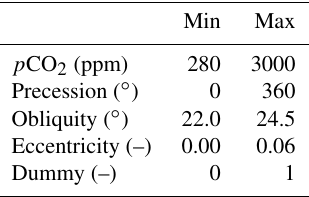
Table 1. Uniform ranges for forcing and dummy